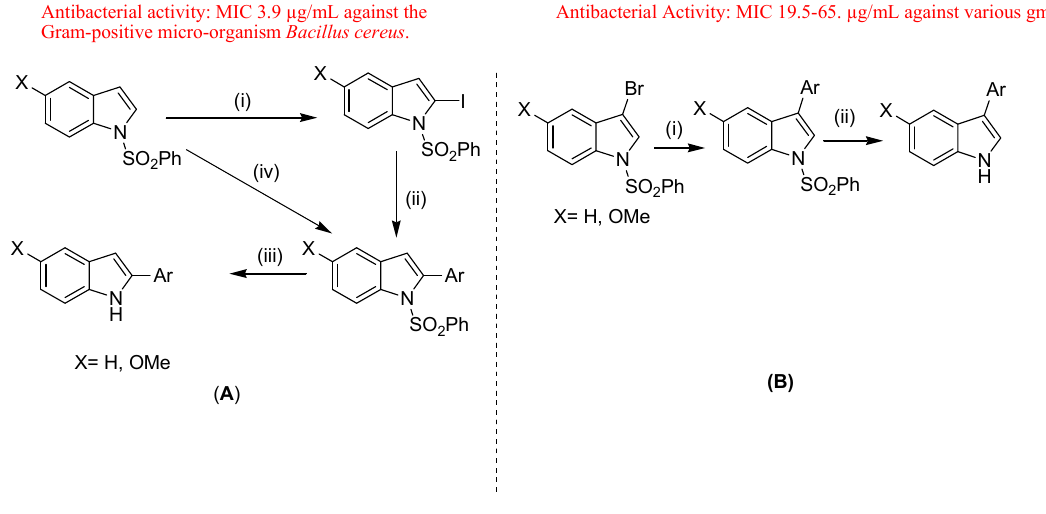
Figure 41. 2- and